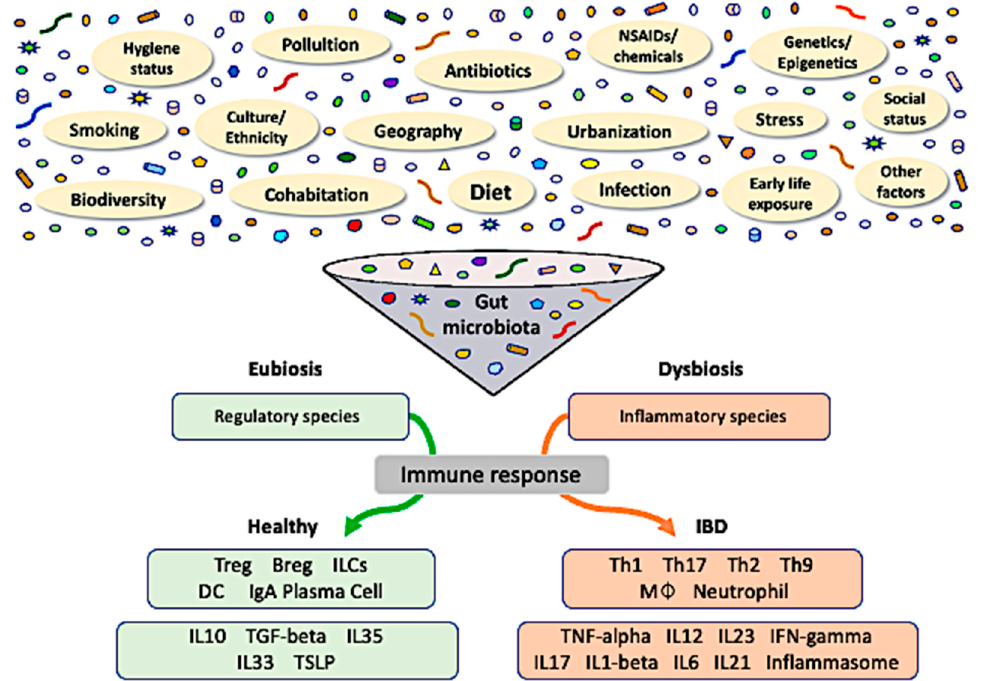
Figure 1. The role of gut dysbiosis in the pathogenesis of inflammatory bowel disease. Gut microbiota reflect an interaction of host genetics with dynamic exposure to innumerable stimuli from the exposome. Crosstalk amongst these factors results in long-standing consequences to the gut microbiota and epigenetic modifications in a multidirectional fashion, potentially affecting susceptibility to diseases. The prevalence of either regulatory (eubiosis) or inflammatory (dysbiosis) species within the gut microbial community determines the respective predominant immune response. Treg, regulatory T-cell; Breg, regulatory B-cell; ILC, innate lymphoid cell; IgA, immunoglobulin A; MØ, macrophage; TSLP, thymic stromal lymphopoietin.